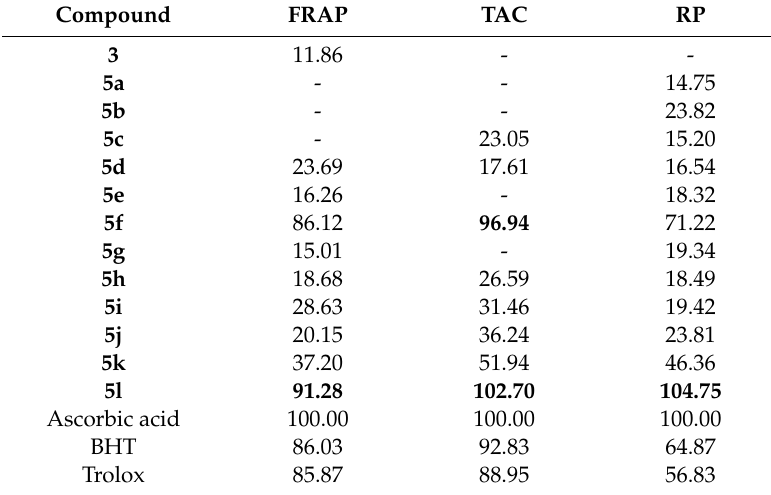
Table 2. Results of the Ferric Reducing Antioxidant Potential (FRAP), Total Antioxidant Capacity (TAC), and Reducing Power (RP) Assays, expressed as % activity of the most active control (ascorbic